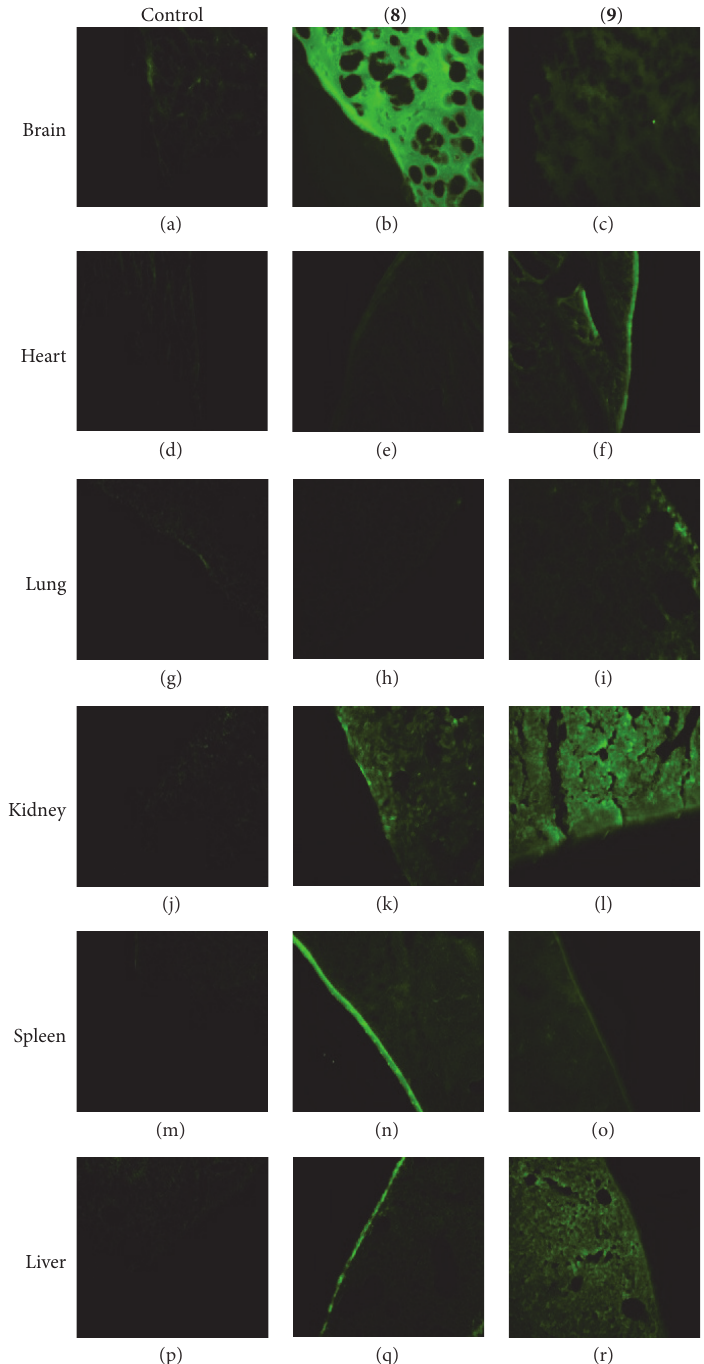
Figure 3: Distribution tests in mouse tissues (left column: control, middle: ( 8 ), and right: ( 9 )). Fluorescence micrographs of ((a)–(c)) brain, ((d)–(f))heart, ((g)–(i))lung,((j)–(l))kidney, ((m)–(o))spleen, and((p)–(r))livertissuesections,isolated frommice20 minafter ip injection. Exposure times (ms); brain: 5000, heart: 1000, lung: 5000, kidney: 2000, spleen: 2000, and liver: 2000. 𝜆 from